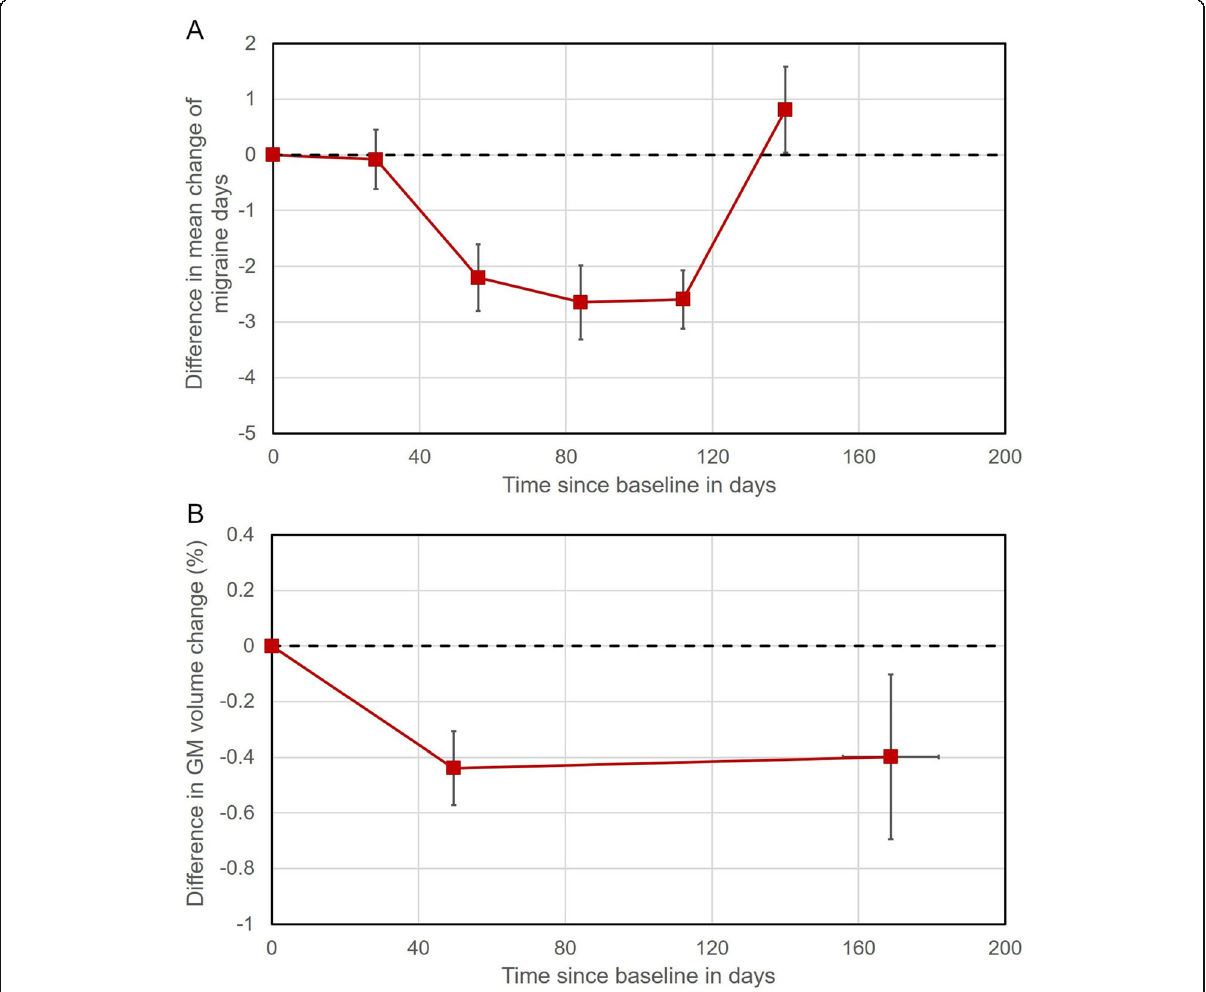
Fig. 4 Clinical and structural changes following tDCS treatment. Change in monthly migraine days depicted as difference in days between verum and sham tDCS group ( A ). Change in GM volume depicted as difference in percent between verum and sham tDCS group ( B ). Negative values represent less migraine days, respectively lower GM volume in the verum tDCS group compared to the sham tDCS group. All values are normalized to the baseline